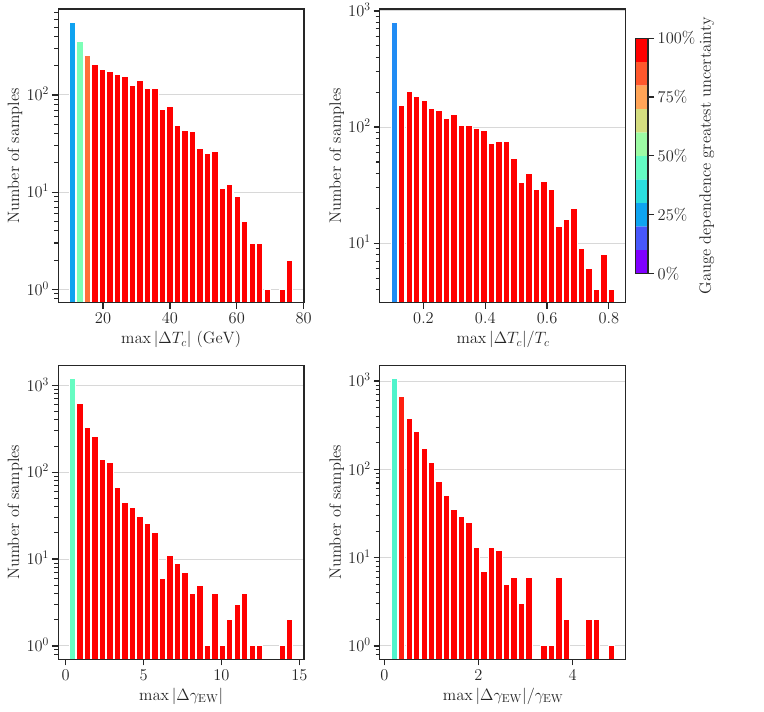
Figure 15 . Distributions of maximum change in the critical temperature (upper) and transition strength (lower) for samples shown in figure 14. The bars are colored by the fraction of points for which gauge dependence was the greatest source of